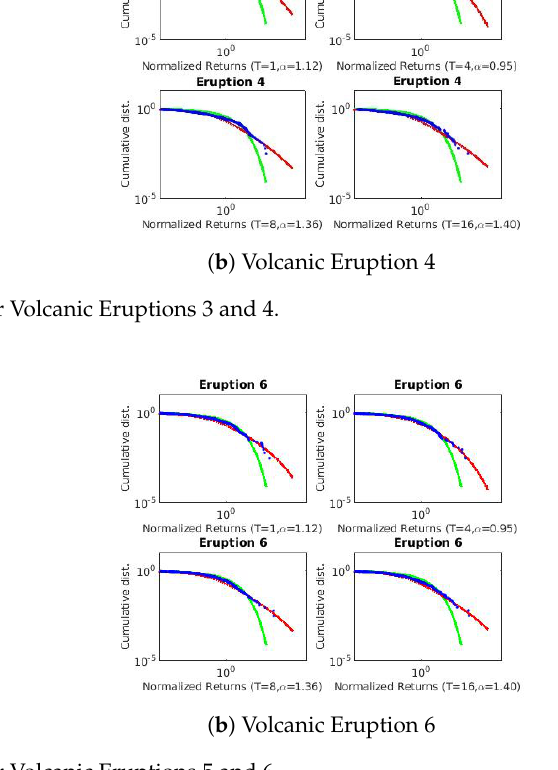
Figure A9. Lévy model fit for Volcanic Eruptions 5 and